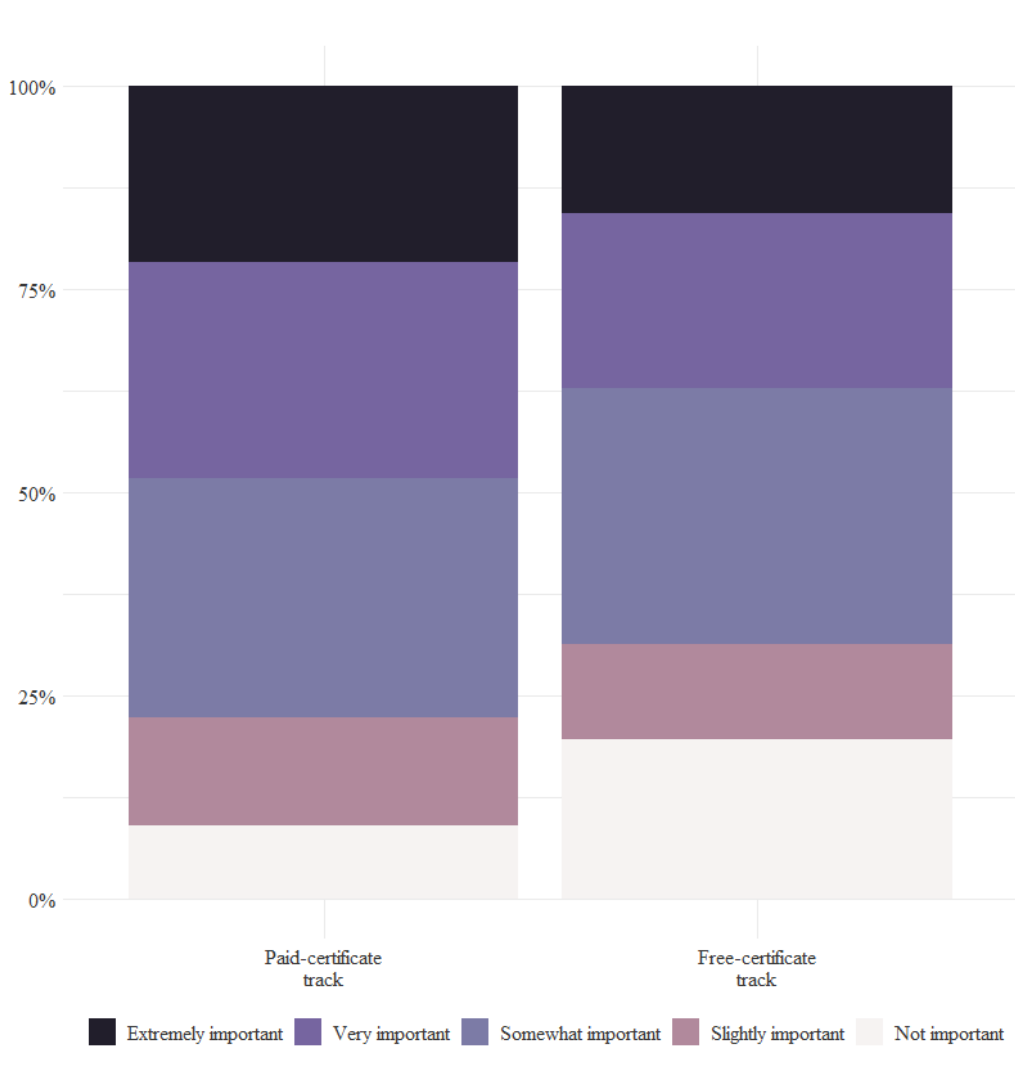
Figure 3. Case study 2: Importance of earning a certificate on entrance